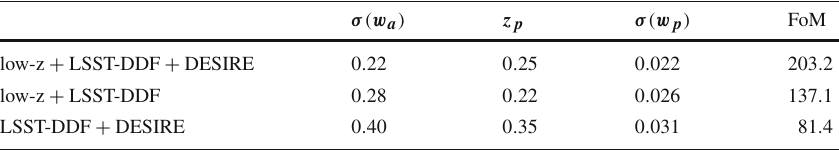
Table 15 Cosmological performance of the simulated surveys σ ( w a ) z p σ ( w p ) FoM low-z + LSST-DDF + DESIRE 0 . 22 0 . 25 0 . 022 203 . 2 low-z + LSST-DDF 0 . 28 0 . 22 0 . 026 137 . 1 LSST-DDF + DESIRE 0 . 40 0 . 35 0 . 031 81 .